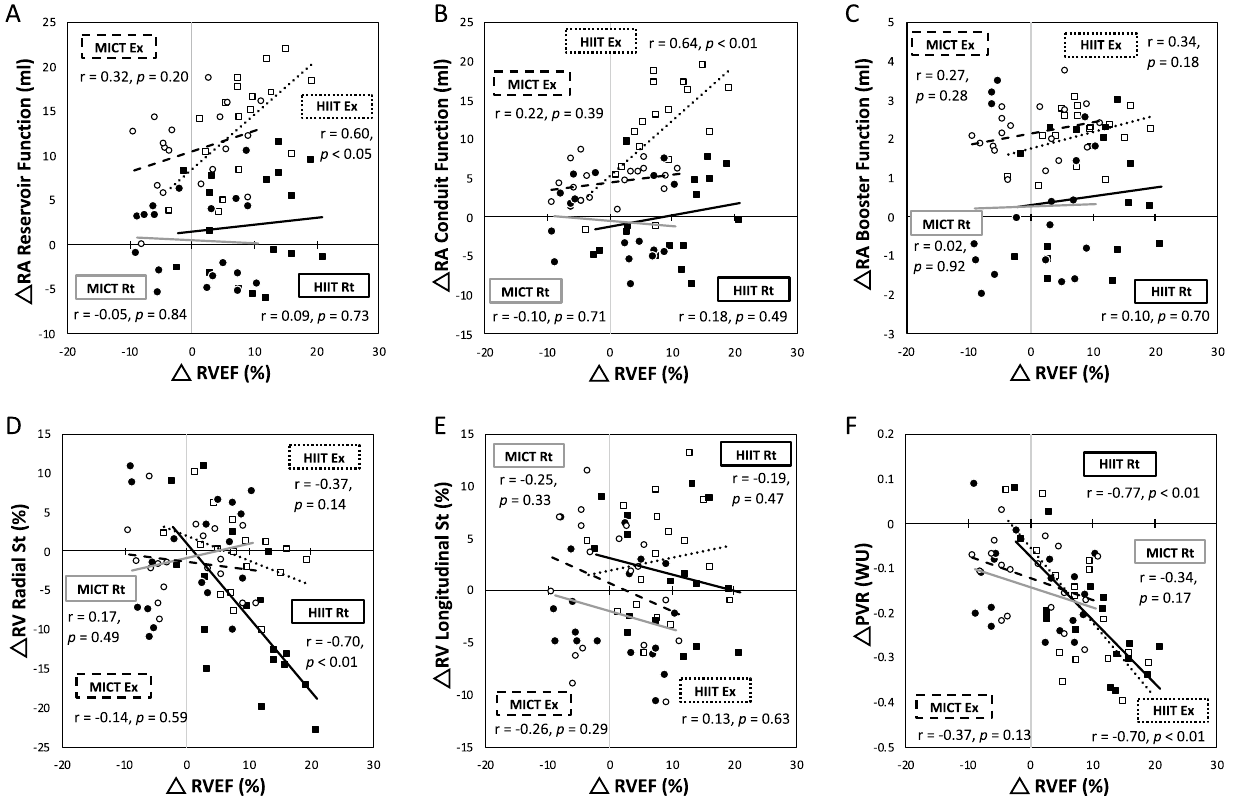
Figure 3. Correlations between changes in RVEF and RA functions, RV mechanics and PVR at rest or during HE following various interventions. RA, right atrium; RV, right ventricle; HIIT, high-intensity interval training group; MICT, moderate-intensity continuous training group; Ex, during HE; Rt, at rest. RVEF, right ventricle ejection fraction; St, strain; PVR, pulmonary vascular resistance. (closed circles), MICT Rt; ○ (open circles), MICT Ex; ■ (closed squares), HIIT Rt; □ (open squares), HIIT Ex; Δ, postintervention minus preintervention. ● The solid line indicates the trend line of HIIT Rt; the dotted line indicates the trend line of HIIT Ex; the gray line indicates the trend line of MICT Rt; and the dashed line indicates the trend line of MICT